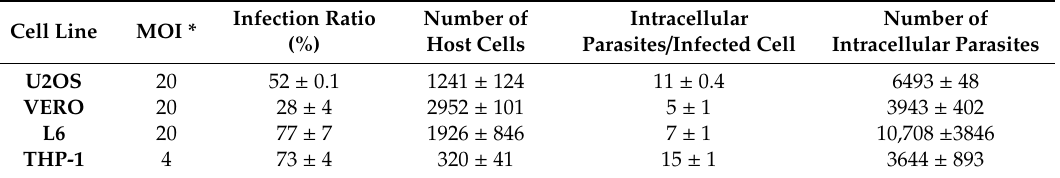
Table 1. General phenotypic parameters yielded by T. cruzi Y-H10 infection with di ff erent host cell lines. Cell